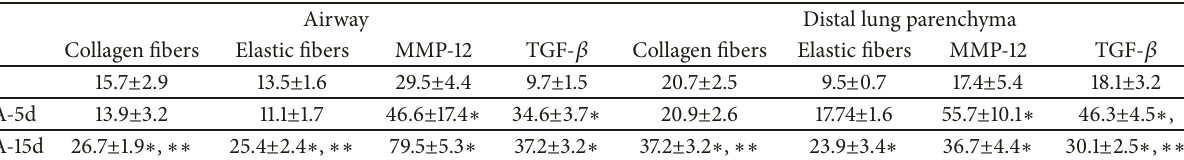
Table 4: ROFA-induced extracellular matrix remodeling : after both five (ROFA-5d) and fifteen instillations (ROFA-15d), mice presented an increase in the number of neutrophils and inflammatory cells that express nNOS and iNOS around airways and in distal lung parenchyma. ThemacrophagesweresignificantlyincreasedonlyinROFA-15dgroupscomparedtosaline. ∗ P < 0.05comparedtosaline; ∗∗ P < 0.05compared to ROFA-5d.